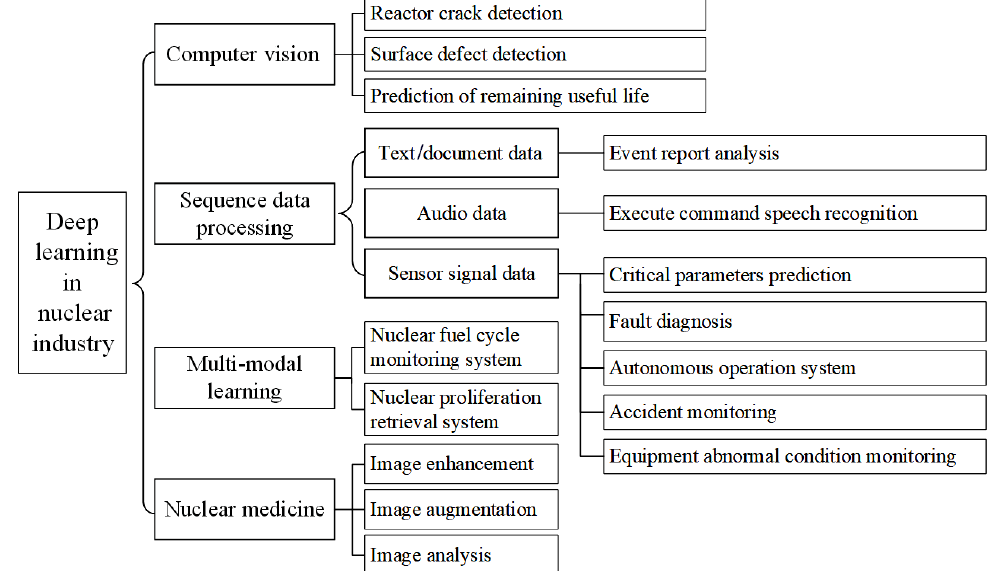
Fig. 4 Research status of deep learning in the nuclear industry. There are four research directions, i.e., computer vision, sequence data processing, multi-modal learning, and nuclear medicine. Among them, sequence data processing includes text document processing, audio processing, and sensor sequence signal